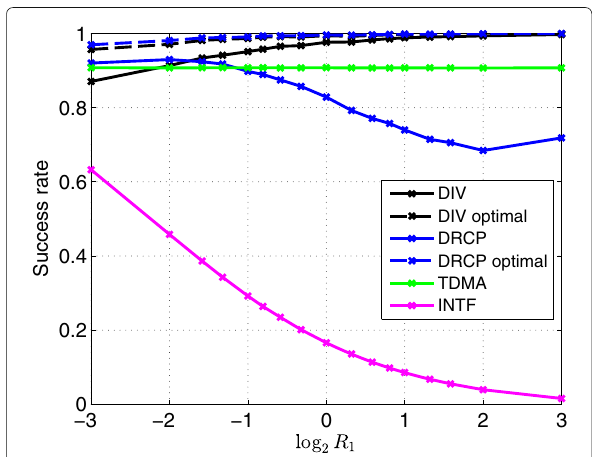
Fig. 3 Success rate of the studied approaches in the transmit power-dominated regime with S min 1 = S min 1 = 0.3 bits/Hz